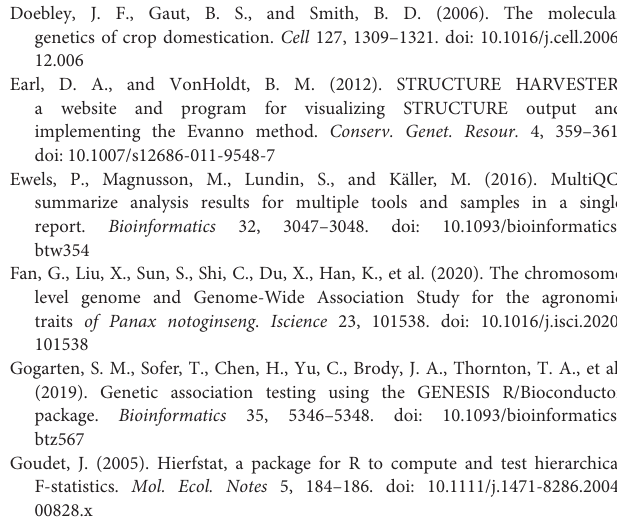
Supplementary Figure S2 | Heat map of Nei’s genetic distances showing the average number of pairwise differences between populations. Supplementary Figure S3 | Coverage of the markers per sample. Supplementary Figure S4 | Pair plot PCAs. Supplementary Figure S5 | PCAs with individuals colored by populations. Supplementary Figure S6 | PCAs with individuals colored by HiSeq lane. Supplementary Figure S7 | PCAs with individuals colored by province. Supplementary Figure S8 | Pearson r 2 correlates of the principal components back to the metadata. The asterisk symbol indicates significant correlation of the metadata on the specific PCA axis. Supplementary Figure S9 | Admixture plots for k equal two to eight. Supplementary Figure S10 | Admixture plots for K = 2 sorted by samples of wild vs. cultivated origin. Supplementary Table S1 | Voucher specimen information. Supplementary Table S2 | Populations’